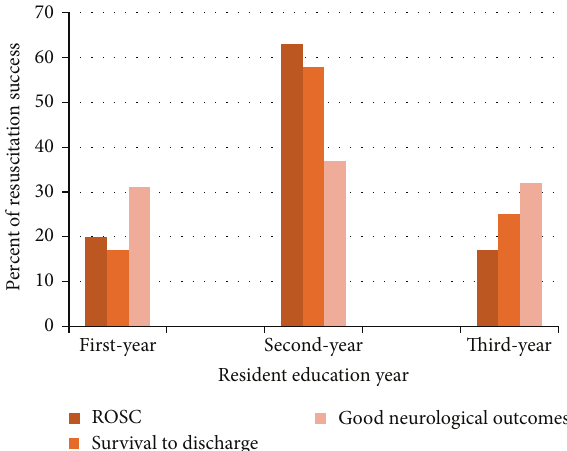
Figure 3: Education level of the resuscitation resident.